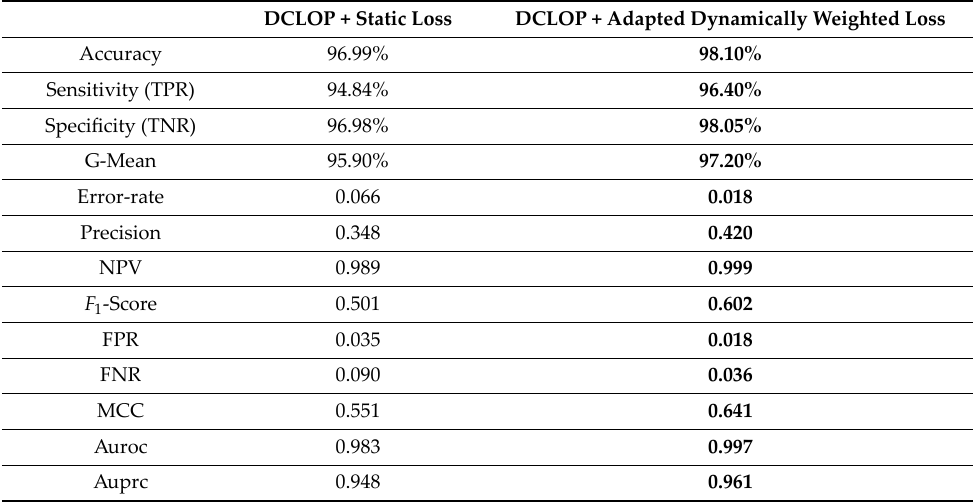
Table 5. Anomaly detection performance evaluation results for